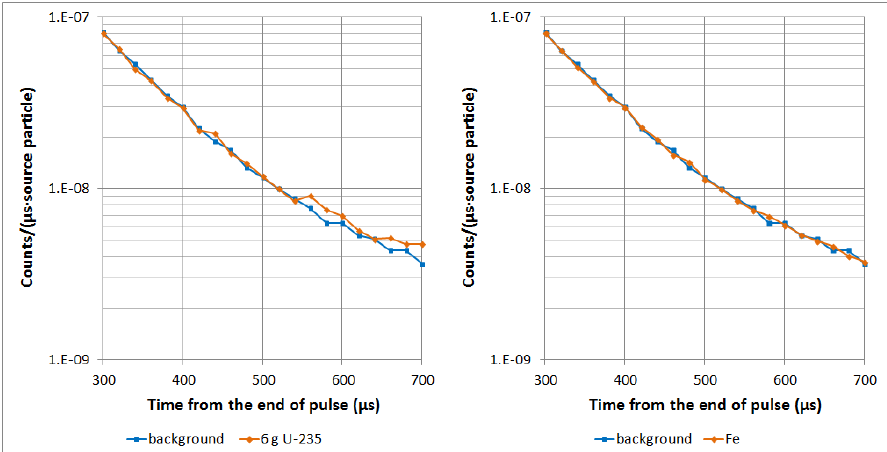
Figure 6. Experimental results of a measurement performed by the NAI device. The left panel shows the deflection of the measured signal coming from a sample with fissile material compared to background signal (when cavity is empty). The right one shows a similar comparison where the measured sample does not contain fissile material. The relative error σ B / ∆ B = 0.09 for each of the three train pulses